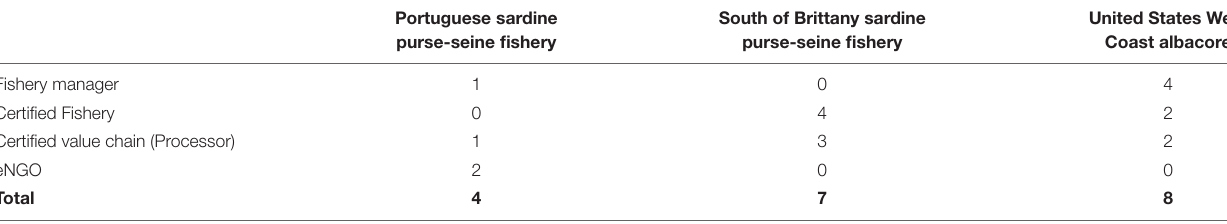
TABLE 1 | Survey respondent numbers by stakeholder group and fishery.